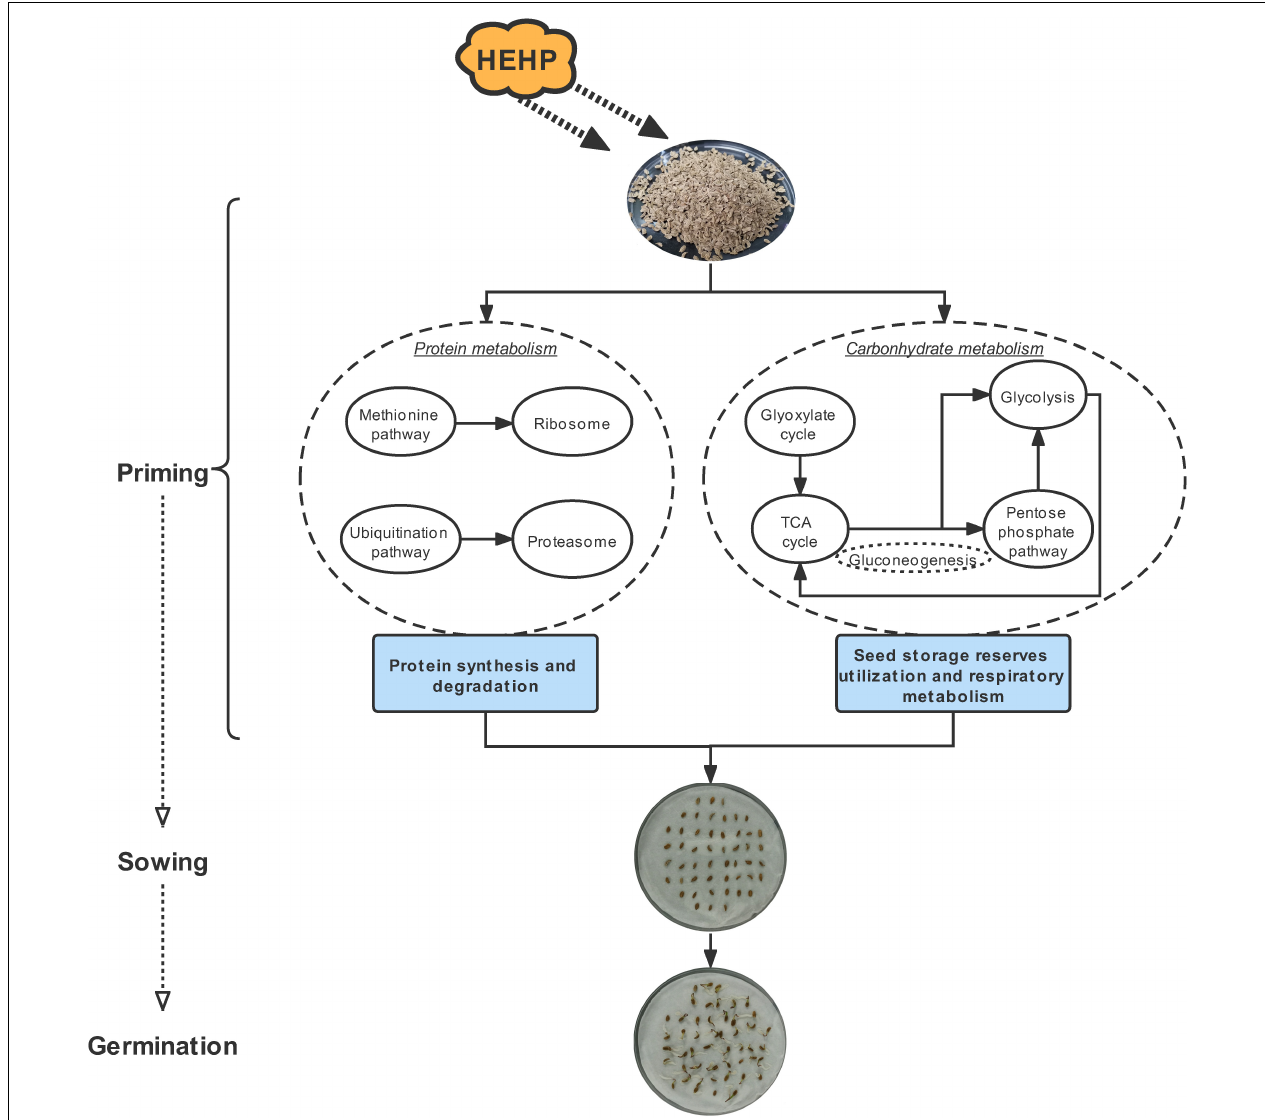
FIGURE 9 | A possible regulation pathway of HEHP promoting carrot seed